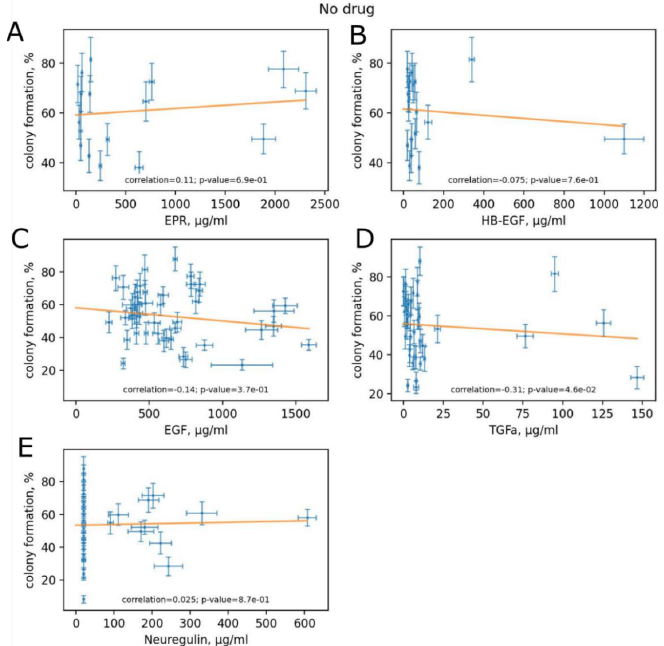
Figure 5. Concentrations of HER ligands in serum vs. clonogenicity without trastuzumab: ( A ) epiregulin; ( B ) HB-EGF; ( C ) EGF; ( D ) TGFa; ( E ) neuregulin. The data are presented as mean ± standard deviation from three independent replicates.